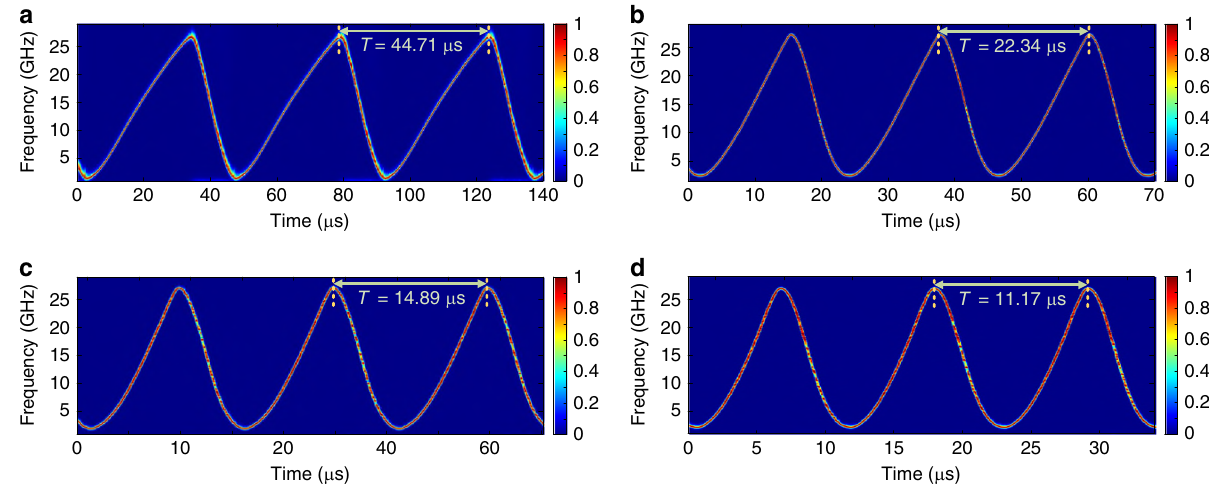
Fig. 7 Spectrogram of the generated LCMW with different repetition time. a The fundamental repetition time of 44.71 µ s with the V PP of the driving signal applied on the MDR is 469 mV. The generated LCMW with the second, third and fourth harmonic repetition time are shown in ( b , c and d ), the corresponding V PP applied on the MDR are 684, 910, and 1140 mV, respectively.